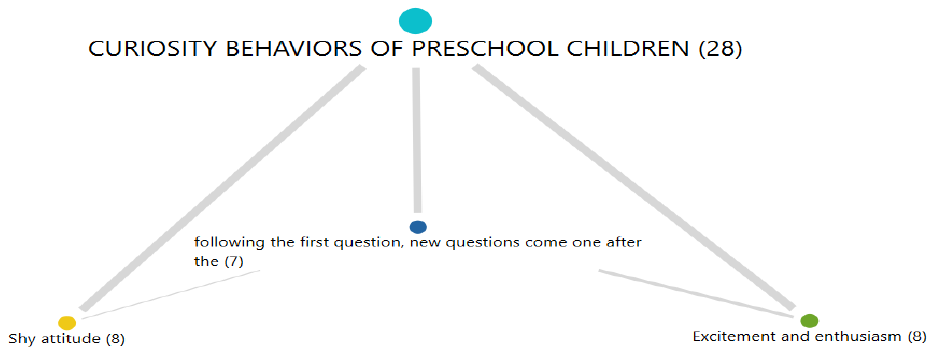
Figure 4. Curiosity behaviors of preschool children.